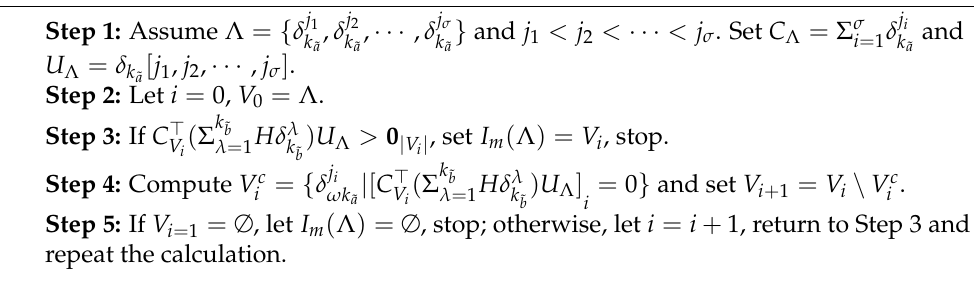
Algorithm 1: Find the largest control-invariant subset I m ( Λ )